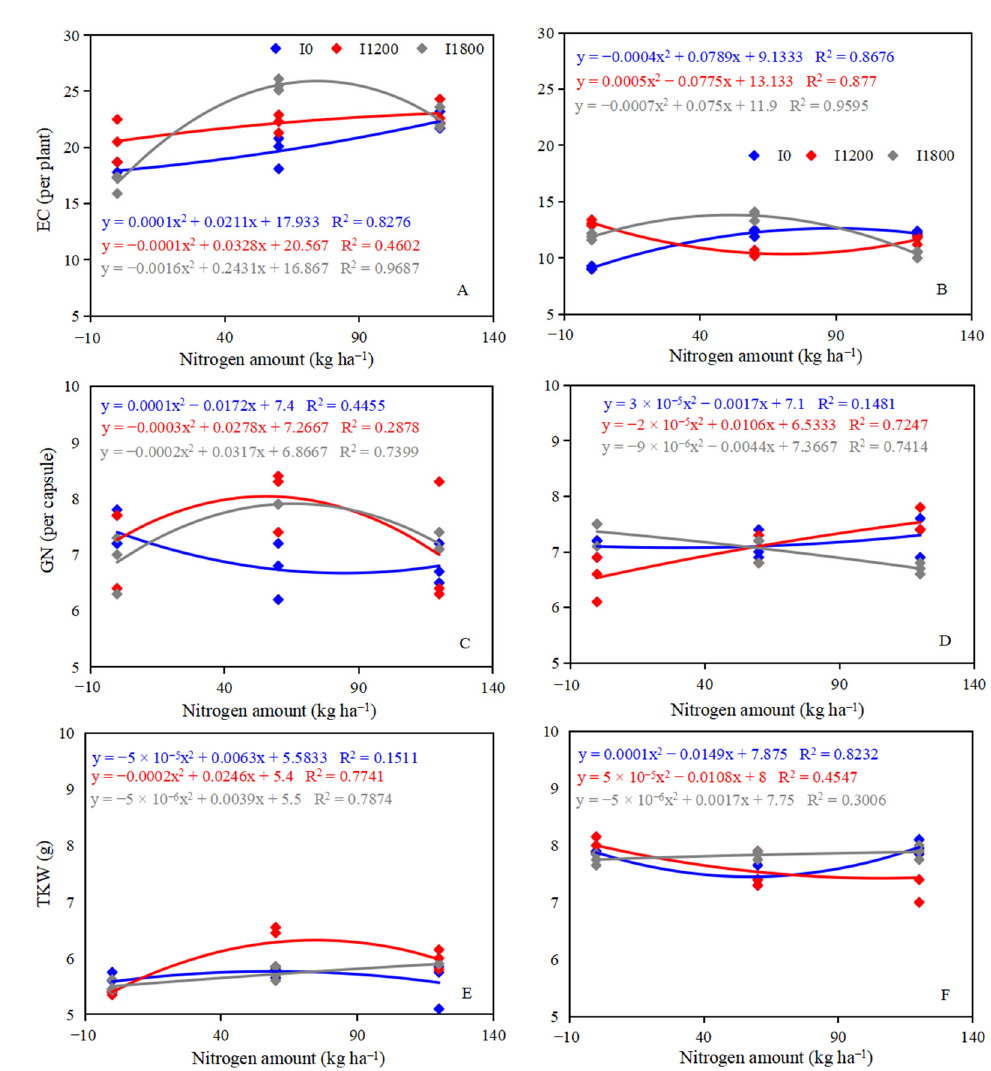
Figure 4. The yield component response to the N application rate in 2017 ( A , C , E ) and 2018 ( B , D , F ). EC, effective capsule number; GN, grain number; TKW, thousand kernel weight.